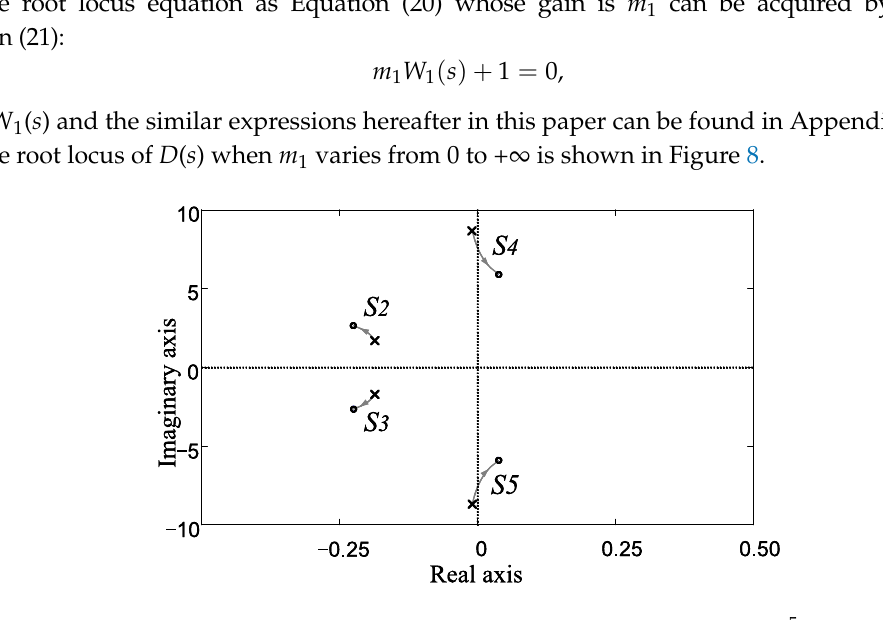
× 10 − 5 Hz/W. 1 changes when m 2 = 5